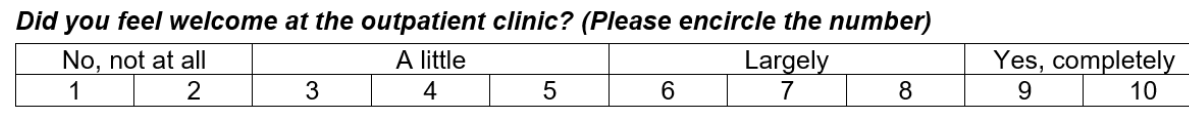
Figure 2. An example of one of the 10 Consumer Quality Index (CQI) questions; this is presented in its 10-point scale